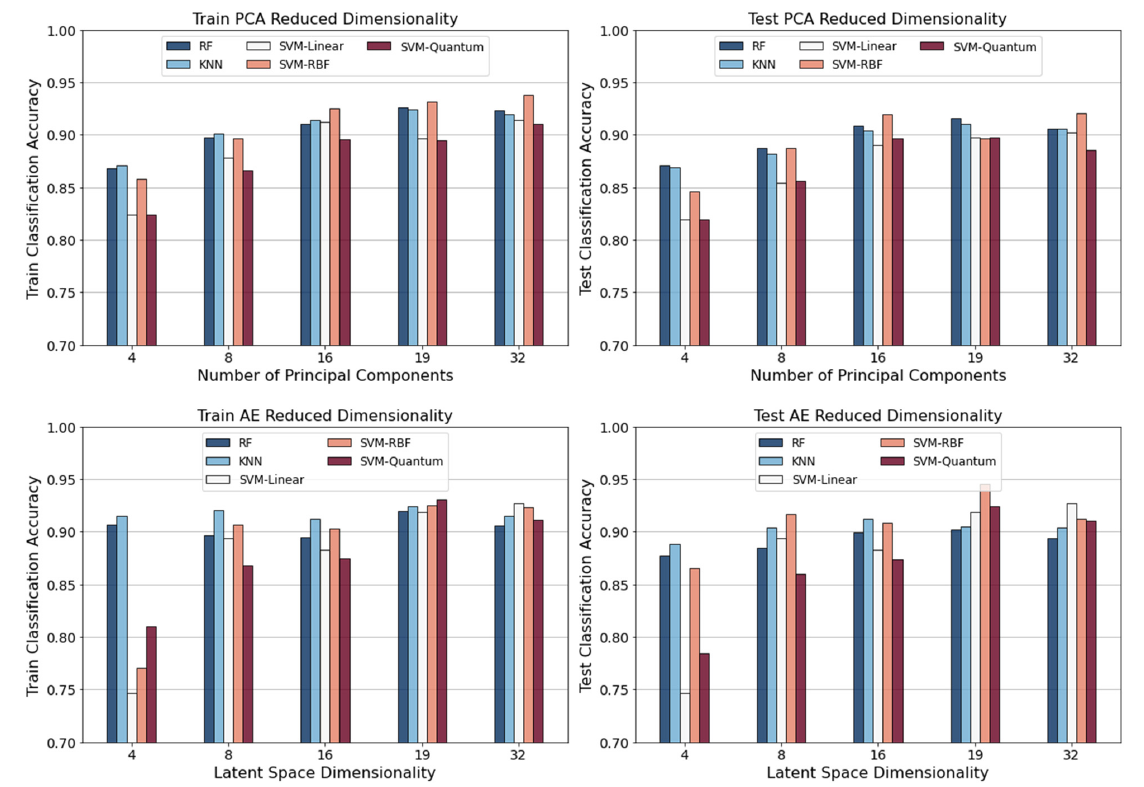
Figure 9. Comparison of models’ train ( left ) and test ( right ) accuracy for reduced dimensionality using PCA ( above ) and AE ( below